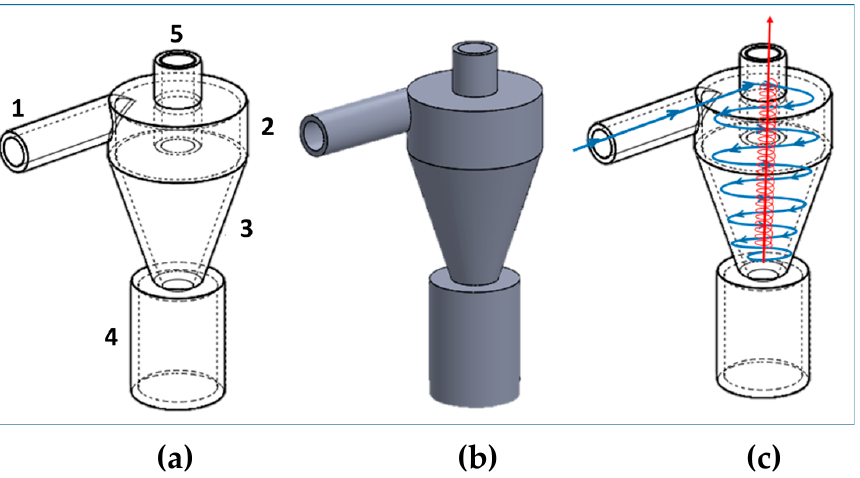
Figure 1. Components of the cyclone: ( a ) numbering cyclone separator elements; ( b ) solid external of a cyclone; ( c ) cyclone internal flow pa tt ern.